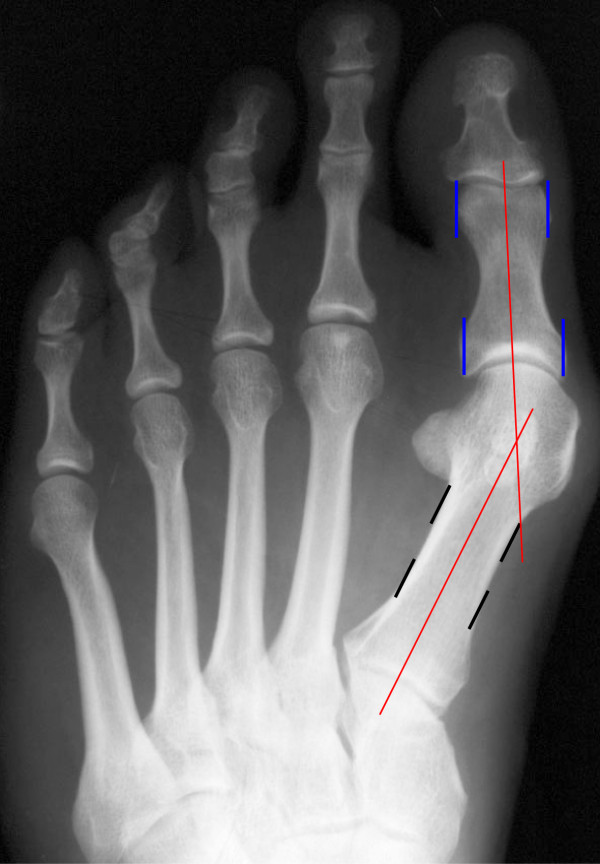
Shaft bisection (SB) measuring method.